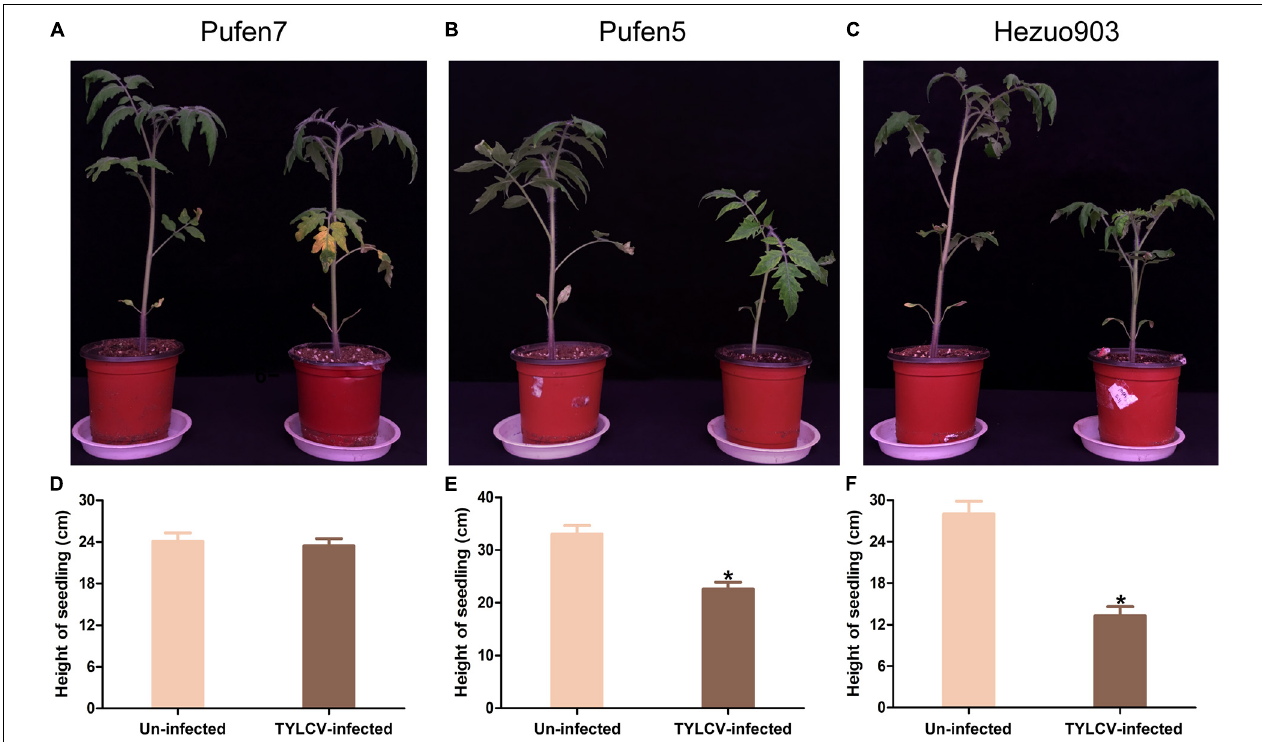
FIGURE 1 | Typical images and height of un-infected and tomato yellow leaf curl virus (TYLCV)-infected tomato plants of different cultivars. (A–C) Image of Pufen7, Pufen5, and Hezuo903. (D–F) Height of un-infected and TYLCV-infected tomato plants. Photographing and measurement of plant height were conducted 4 weeks post virus inoculation. Values are means ± SEM in panels (D–F) ( n = 8–15). *Above columns indicate significant differences (independent t -test, p < 0.05).